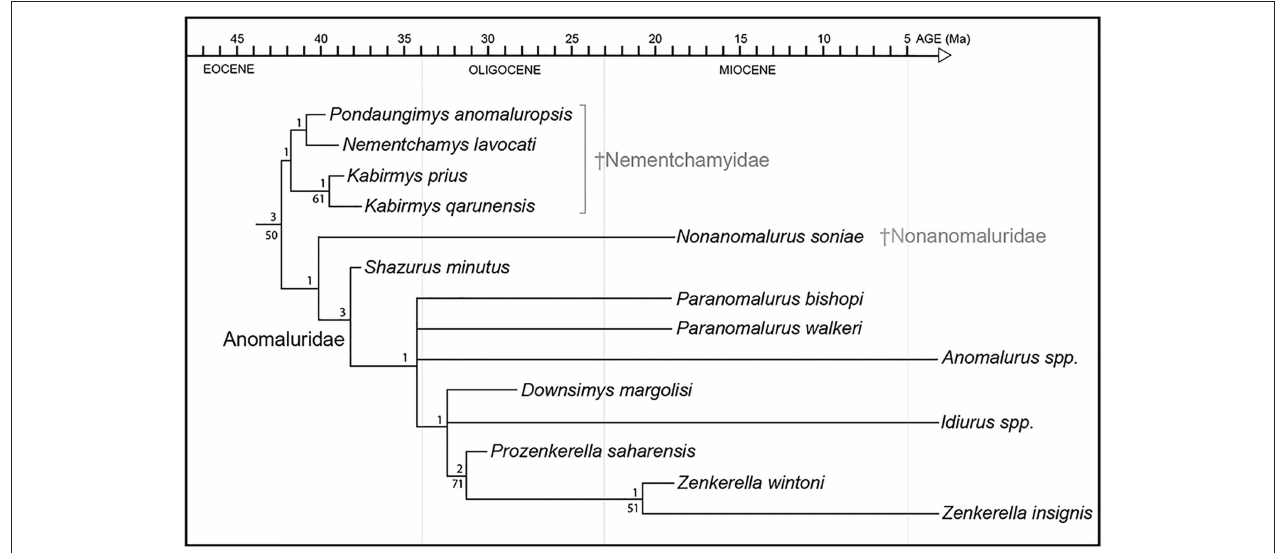
FIGURE 9 | Phylogenetic relationships among living and fossil anomaluroids incorporating stratigraphic range data for fossil forms. Approximate geochronological age of fossil taxa equals the youngest point on the line leading to individual taxa (older segments represent ghost lineages required by the tree topology shown here and the stratigraphic ranges of closely related taxa). Ghost lineages should not be confused with calibrated molecular divergence dates. For example, while Idiurus and Zenkerella must have diverged by the early Oligocene according to these results, this is a minimum estimate based on the age and inferred relationships of Prozenkerella . Relative stability of individual clades was assessed using bootstrap ( Felsenstein, 1985) and Bremer support (Bremer, 1994) analyses. Bootstrapping was based on 1000 replicates. Bootstrap values > 50% are shown below branches. Bremer support is given above